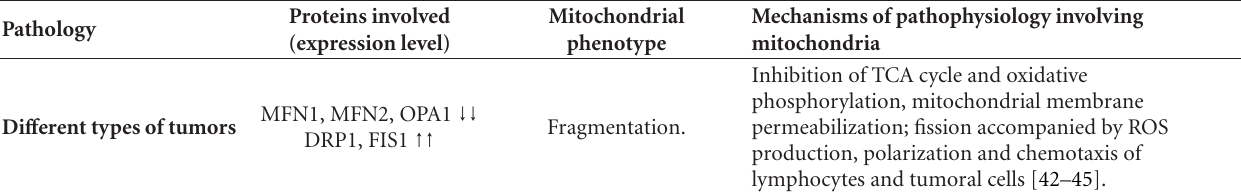
Table 1: Mitochondrial dynamics and